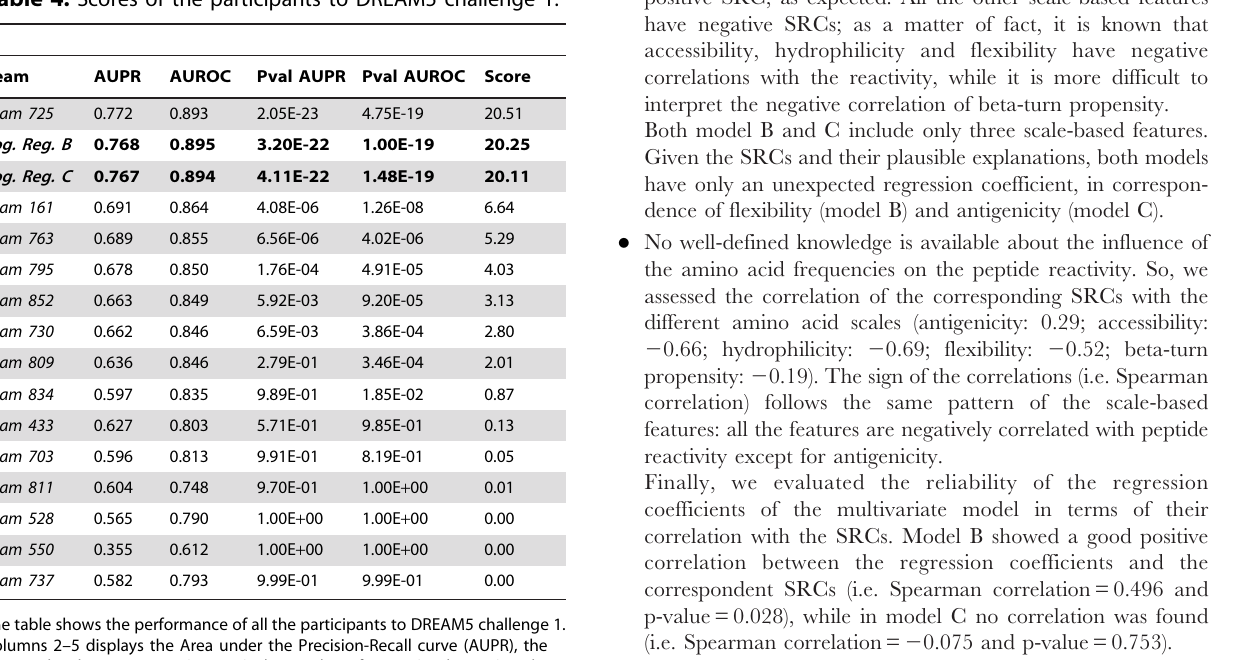
Table 4. Scores of the participants to DREAM5 challenge 1.